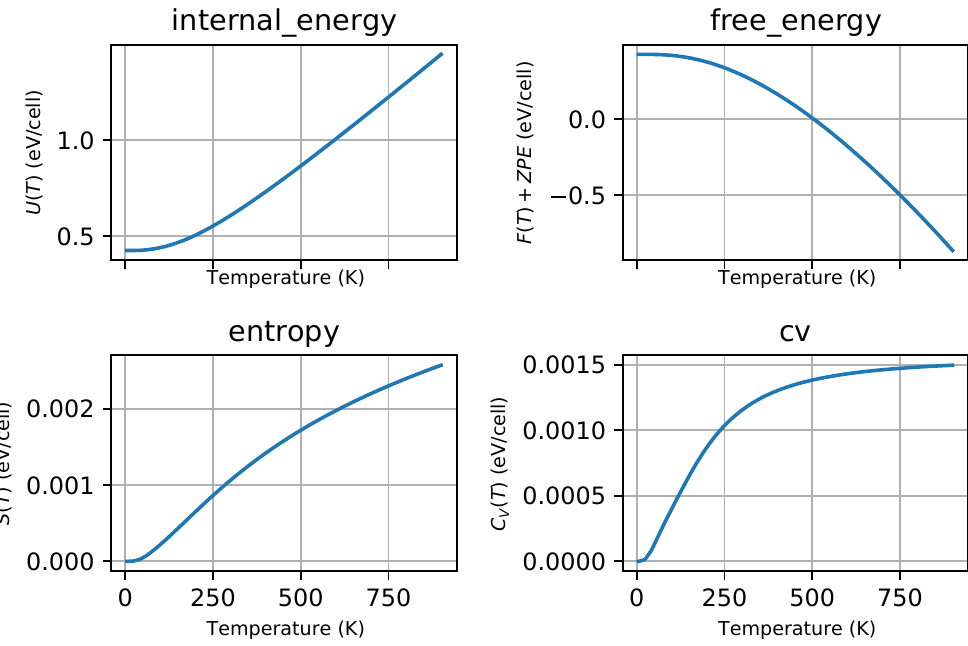
Figure 6. ZrB 2 ( hP6 -P6 3 /mmc-space group, no.194)-thermodynamic properties: internal energy, free energy, entropy and constant-volume specific heat.